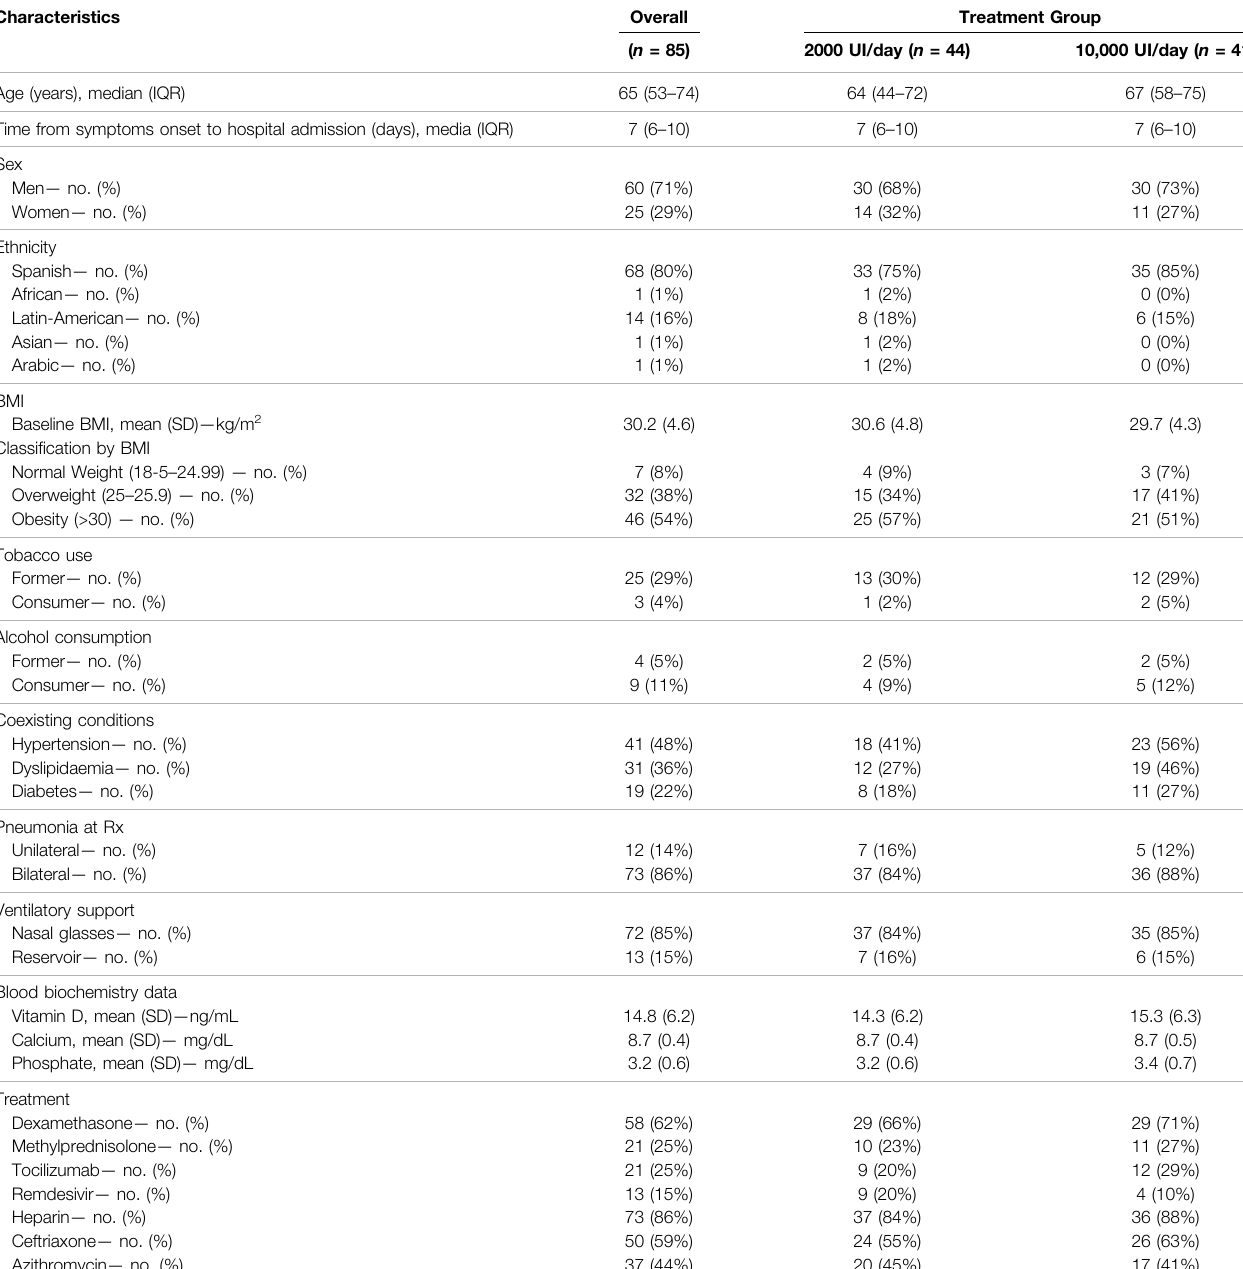
TABLE 1 | Baseline clinical and biochemical characteristics in hospitalized patients with COVID-19 who received 2000 IU/day and 10,000IU/day of cholecalciferol.